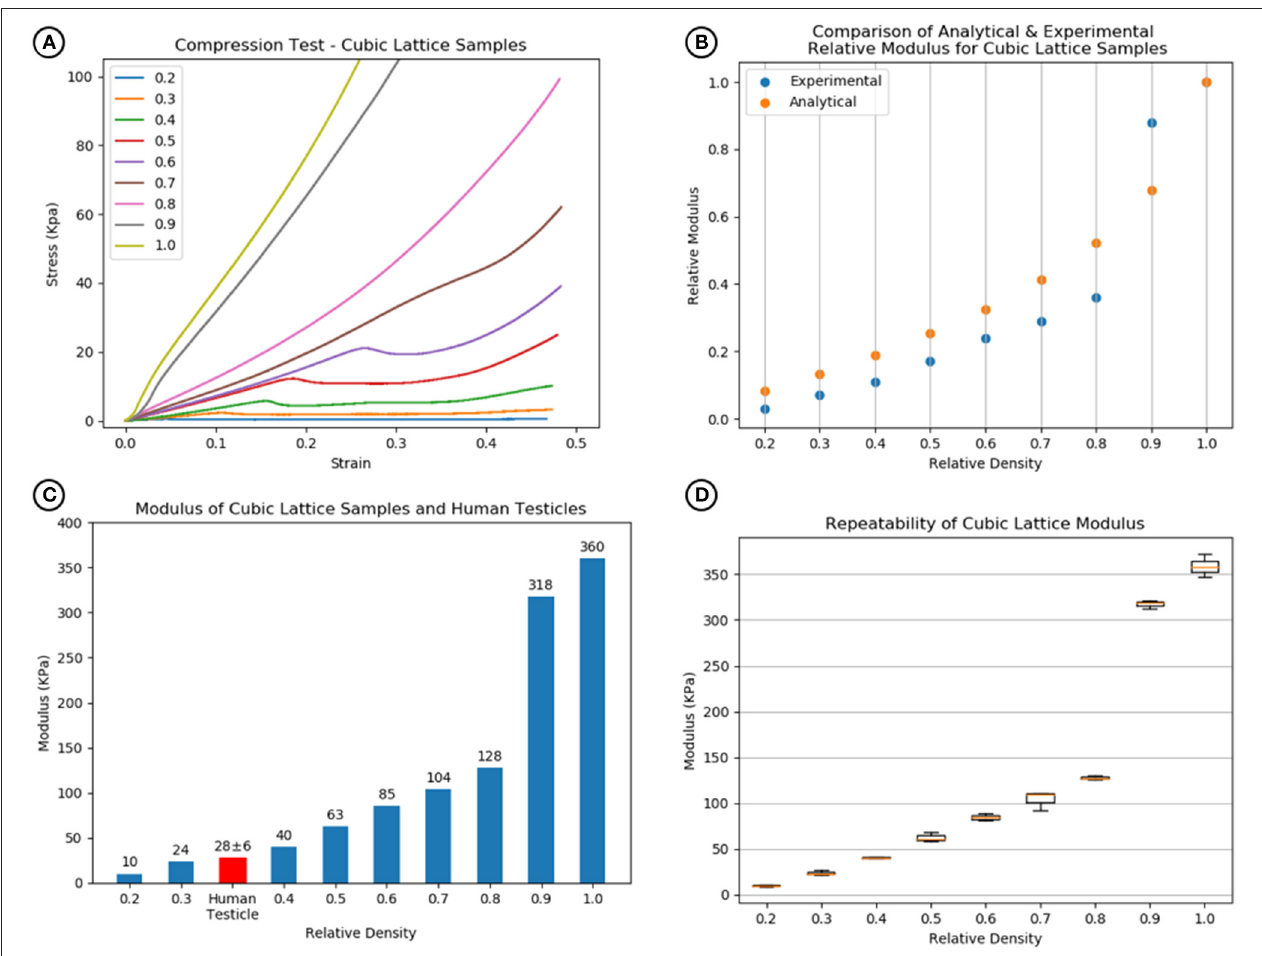
FIGURE 4 | (A) Compression test results of cubic lattice specimens showing increase in stiffness with relative density. (B) Comparison of analytical [Equation (1) and (2)] and experimental relative modulus for cubic lattice specimens. (C) Relative densities of 0.3–0.4 match with human testicle stiffness values. (D) The repeatability of the modulus values across a sample size of 3 for each relative